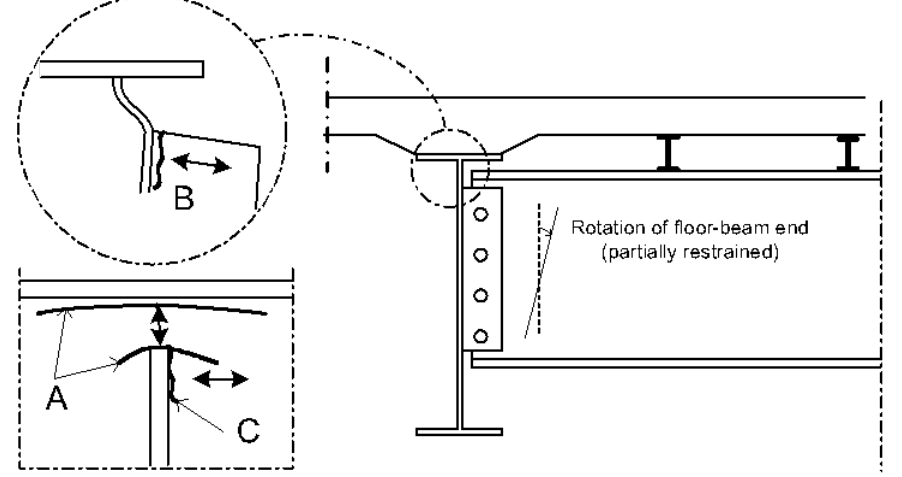
Figure 18. Fatigue cracking in a floor beam welded to the main girder connection.